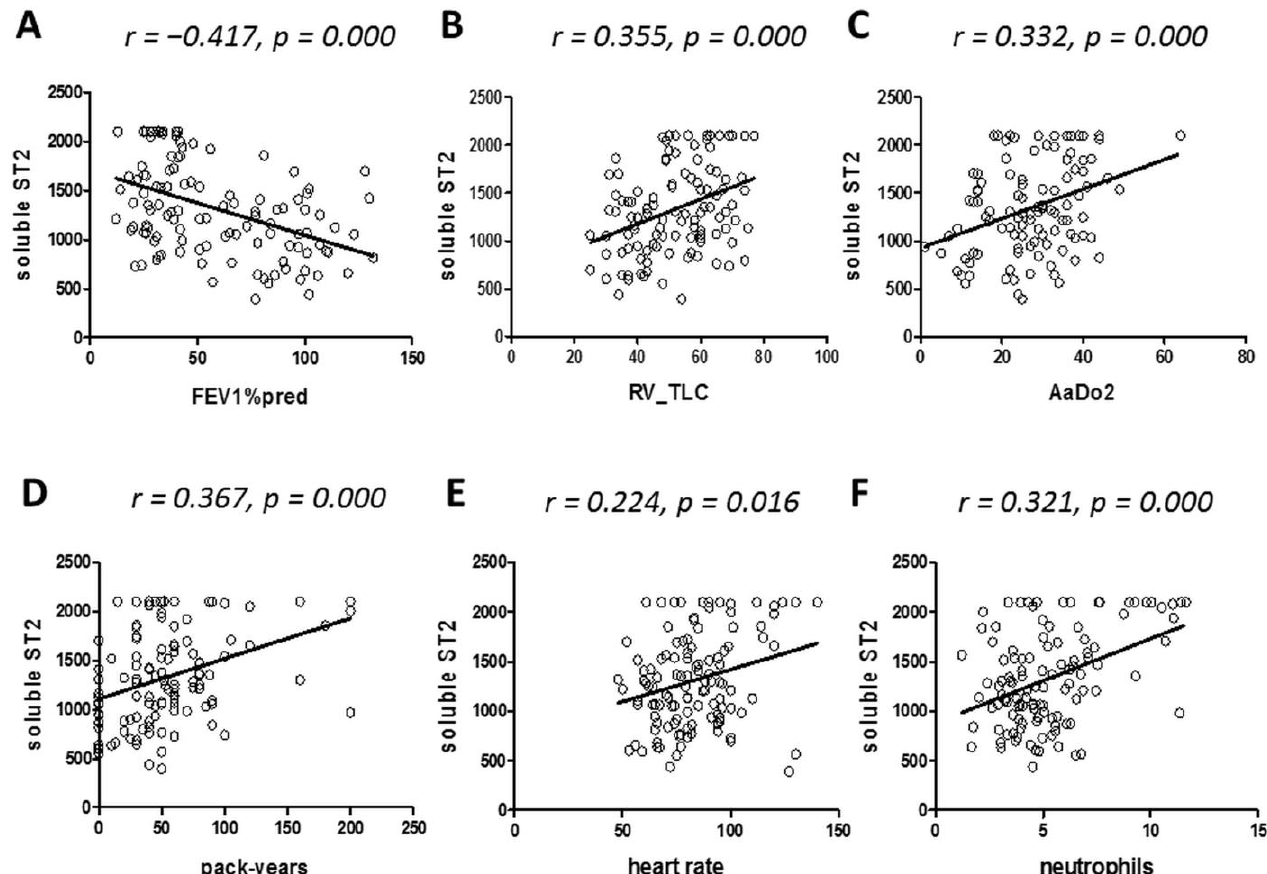
Figure 2. Determinants of soluble ST2 in COPD patients and healthy controls. Univariate correlations between soluble ST2 (in ng/mL) and FEV1% predicted (panel A ), RV and TLC (in L/L) (panel B ), AaDO2 (in mmHg) (panel C ), pack-years (panel D ), heart rate (in bpm) (panel E ) and neutrophil count (in G/L) (panel F ) in the entire study sample ( n = 118). Circulating sST2 was measured as described in the Methods section; p -values < 0.05 were considered significant. Table 2. Multivariate linear regression analysis with soluble ST2 as dependent variable in the total sample (R = 0.684, R 2 = 0.468, F = 16.88, p = 0.000).